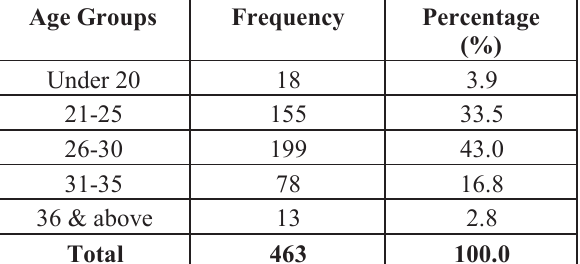
Fig-2: Socioeconomic